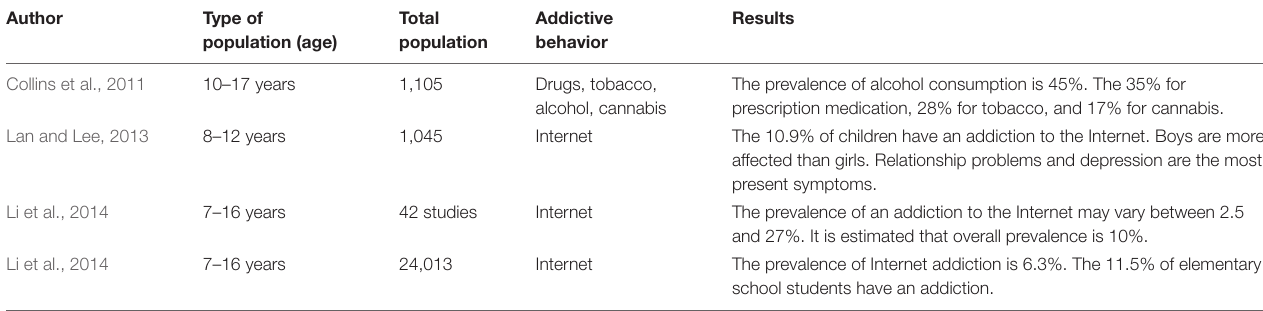
TABLE 4 | Synthesis of prevalence studies.